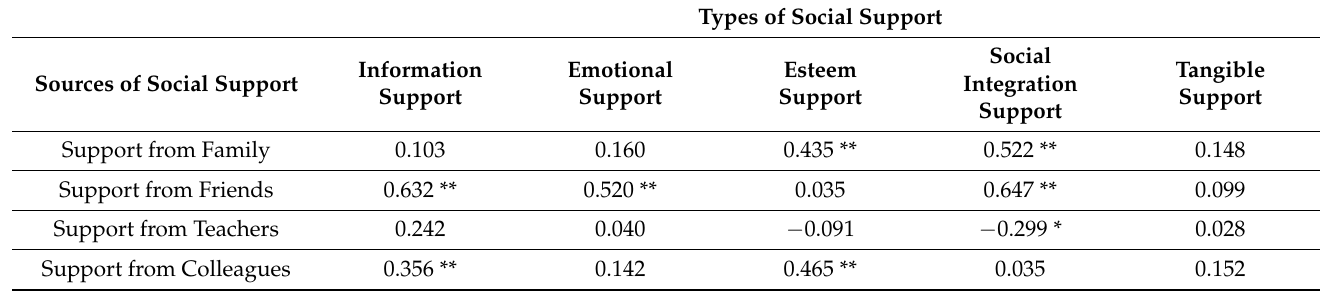
Table 3. Pearson correlation between sources of social support and types of social support accessible to students with disabilities during the COVID-19 pandemic (n =